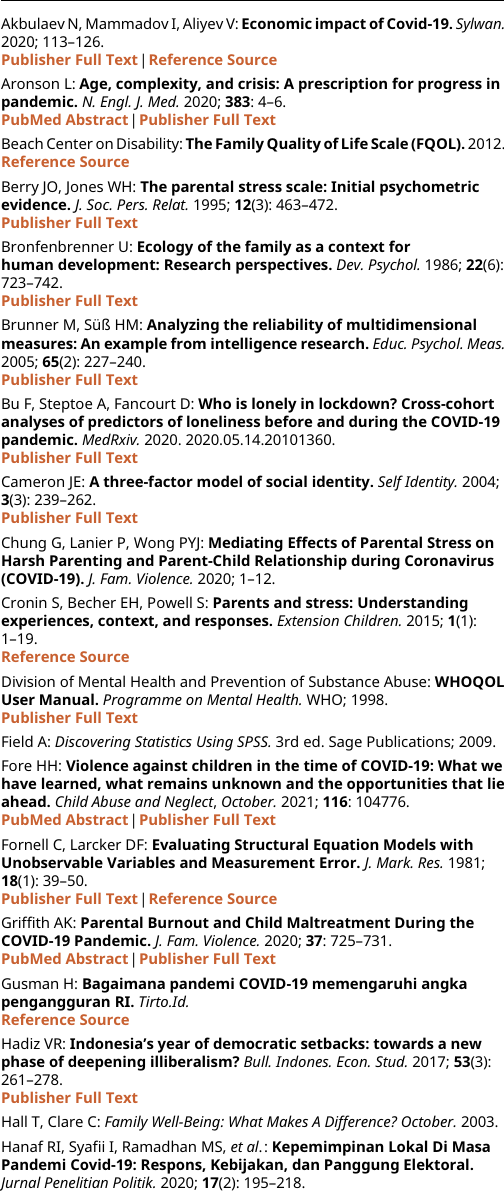
Figshare: Extended data for “ The conditional effect of family resilience on family quality of life during the Covid-19 pandemic ” . DOI: https://doi.org/10.6084/m9.figshare.21342126 (Setiawan et al. , 2022). Data are available under the terms of the Creative Commons Attribution 4.0 International license (CC-BY